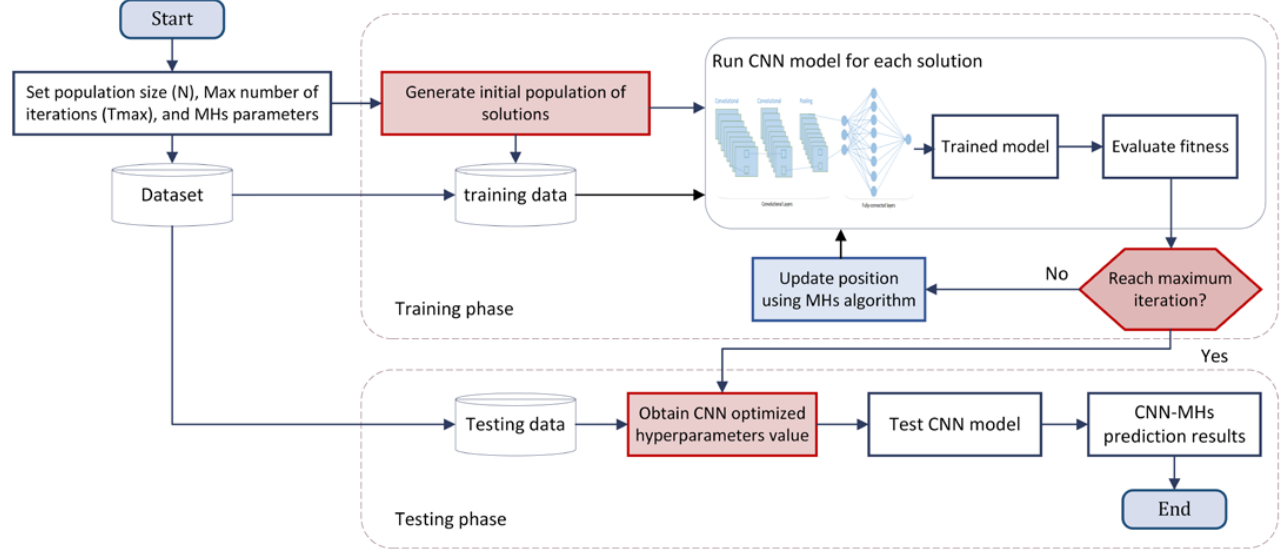
Figure 5 . Improved CNN model with metaheuristic algorithms (MHs)